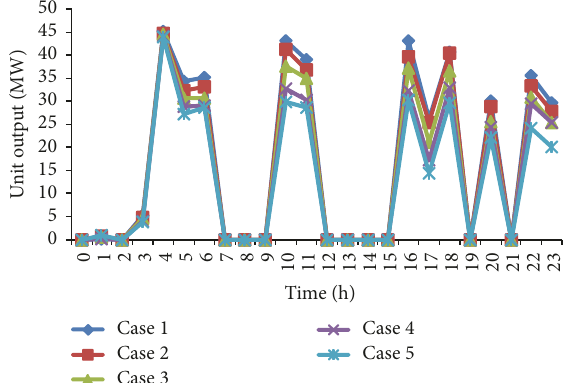
Figure 7: Energy storage power upregulation reserve bidding ca- pacity.